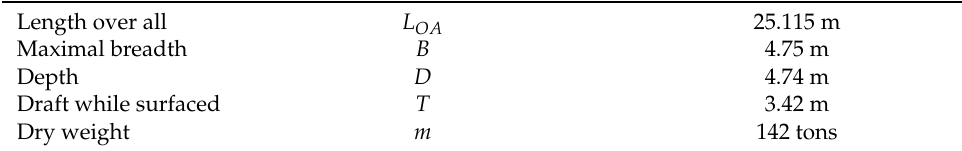
Figure 1. Visual representation of the submarine. Table 1. Main particulars of the